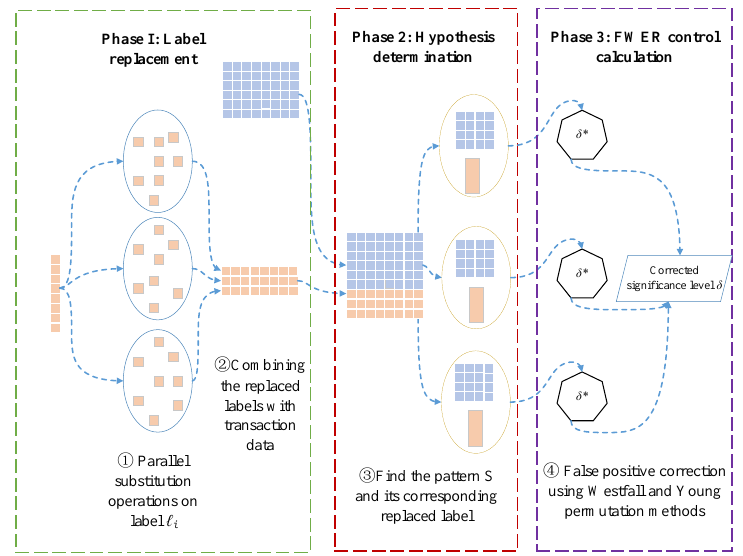
Figure 1. Overall framework of distributed PFWER false positive